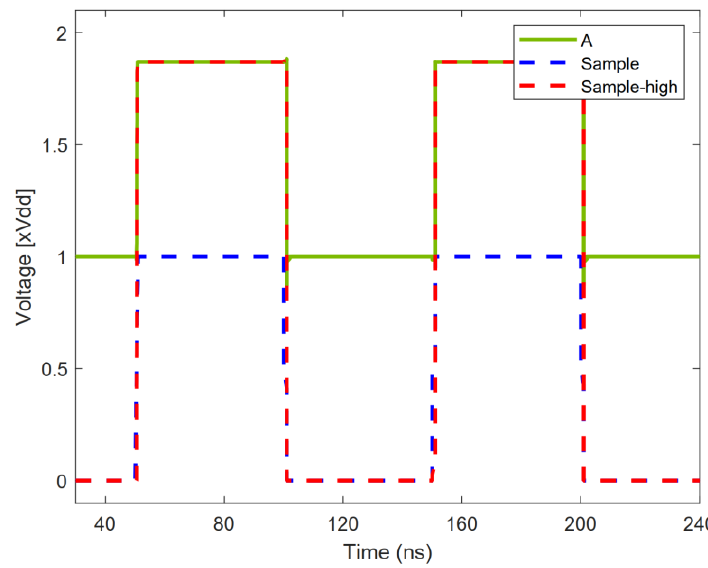
Figure 9. Transient simulation of sampling switch.